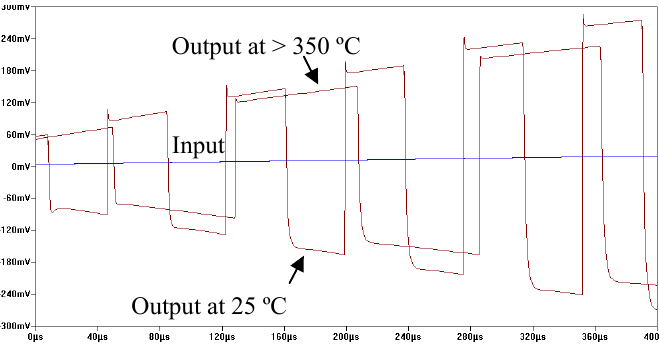
Figure 10. Simulation result of signal conditioning circuitry of thermocouple SiC wireless transmitter.